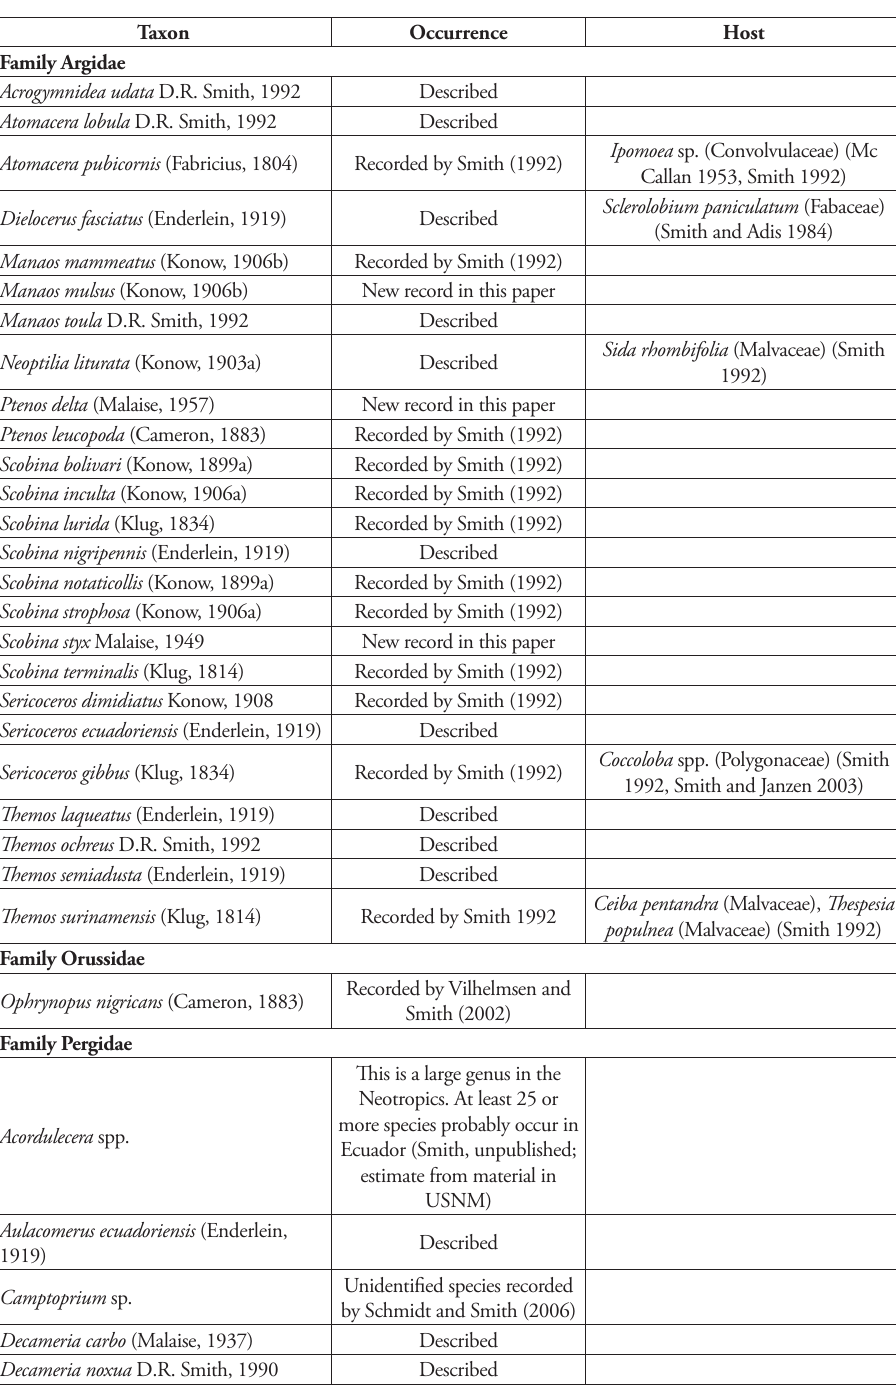
Table 1. Checklist of Ecuador